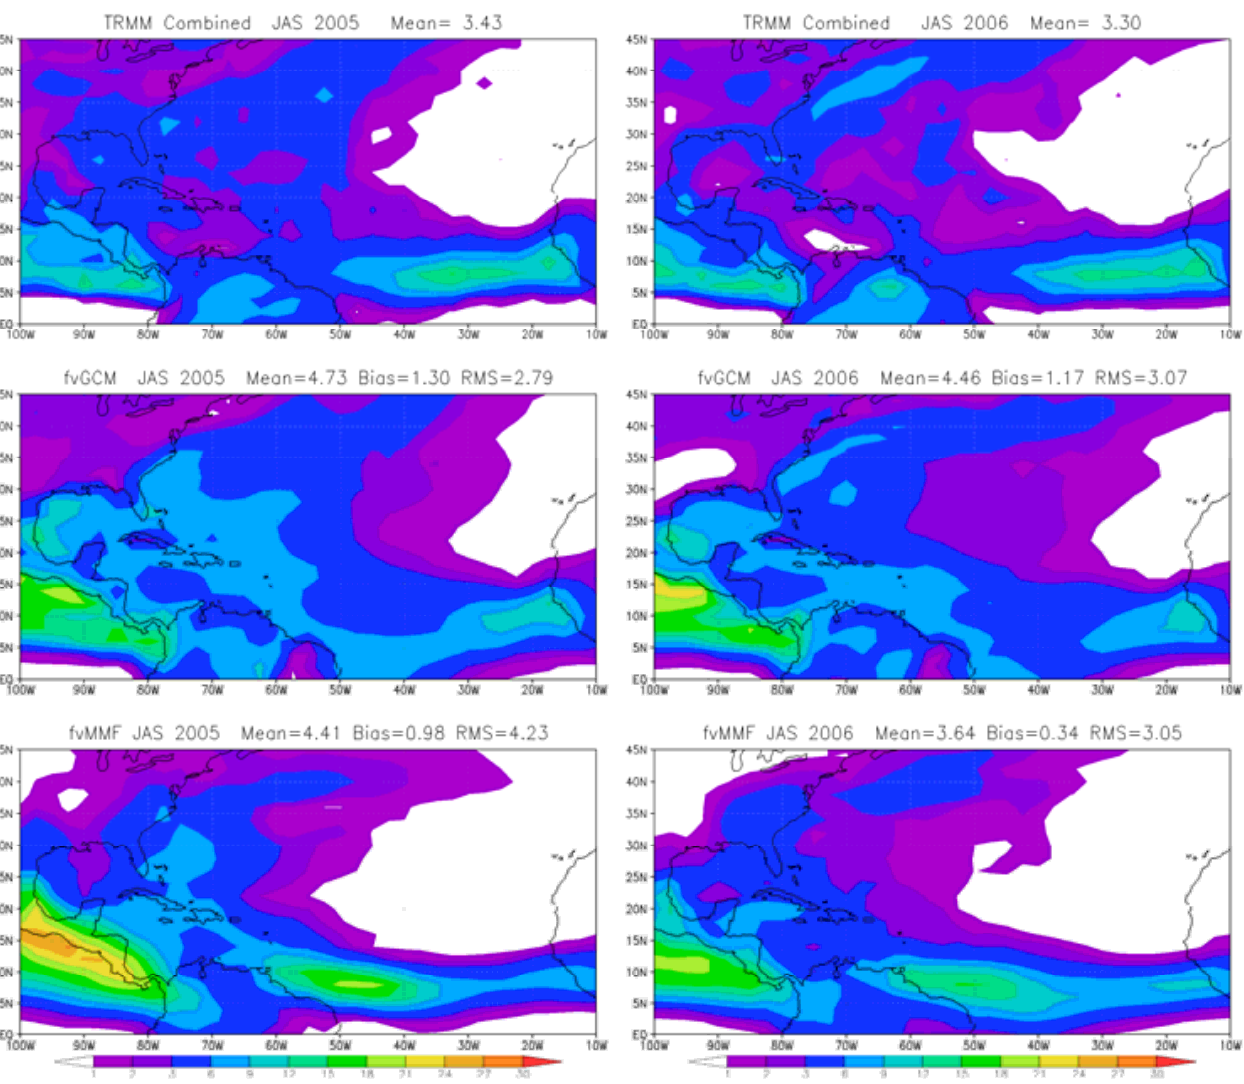
Fig. 4. Mean precipitation rates (mm/day) during the 2005 and 2006 hurricane seasons (JAS) from the TRMM combined product (upper panels), fvGCM (middle panels), and Goddard MMF (lower panels). Both models agree with the observations in simulating more precipita- tion during the 2005 season. The MMF has a better precipitation bias (i.e., 0.98 vs. 1.30 in 2005 and 0.34 vs. 1.17 in 2006) and less rainfall compared to the fvGCM. In addition, the dry areas over the subtropical Bermuda high are more realistic than in the fvGCM. However, the MMF has a higher root mean square (RMS) erro compared to the fvGCM in